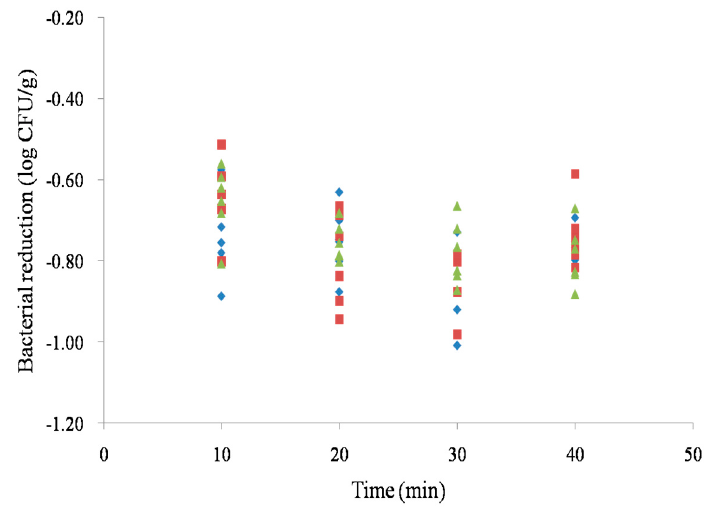
Figure 1. Bacterial reductions of Salmonella on chicken breasts with 20 ( ◆ ), 50 ( ■ ) and 100 ( ▲ ) mg/L of chlorine.